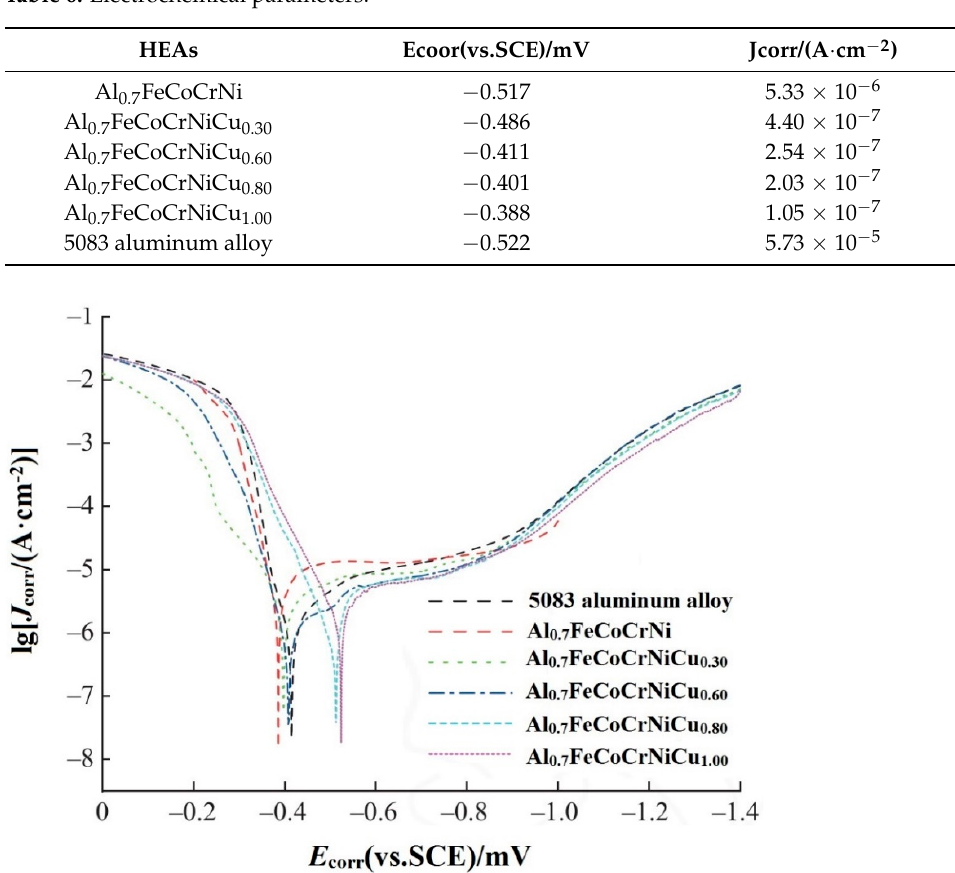
Table 6. Electrochemical parameters.